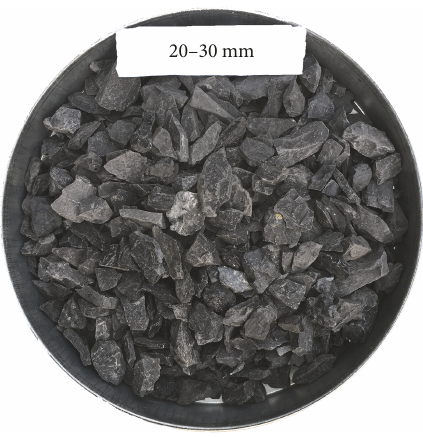
Figure 6: Gangue with particle size 20 – 30